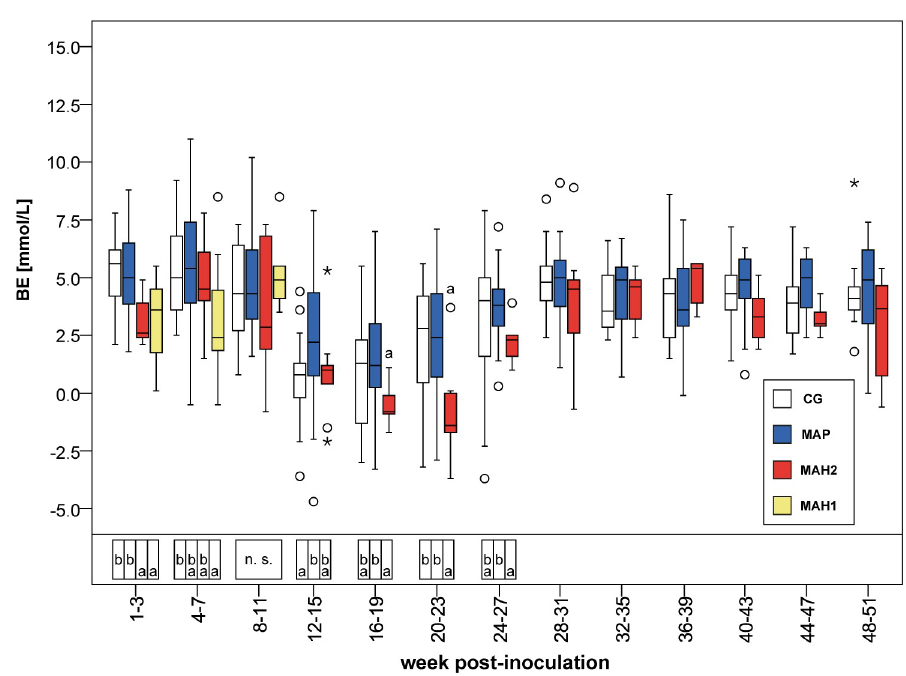
Fig 3. Calculated concentrations of base excess assessed in venous blood. CG, control group. MAP, group infected with Mycobacterium avium subsp. paratuberculosis . MAH 1, sub-group infected with Mycobacterium avium subsp. hominissuis with acute, severe form of infection. MAH 2, sub-group with chronic form of infection. Different letters indicate significant differences between groups within one period (Mann-Whitney U -test, P < 0.05). n.s., no significant differences between groups in the given period. From 28 th week onwards Mann-Whitney U -test was not performed due to reduced numbers of observations. Significant differences within groups (Friedman test, P < 0.05) from 1 st -3 rd to 24 th -27 th wpi are given in S3–S5, and S10 Tables.